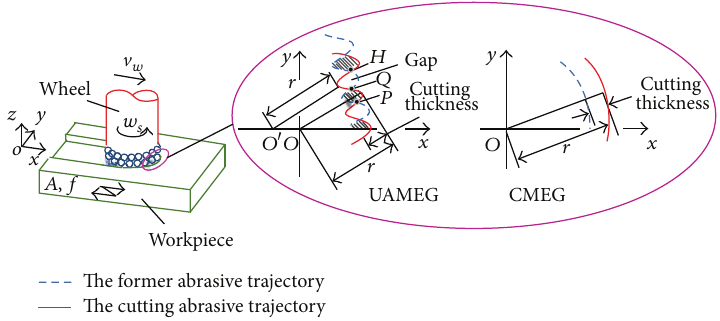
Figure 1: Machining process of UAMEG and conventional micro end grinding